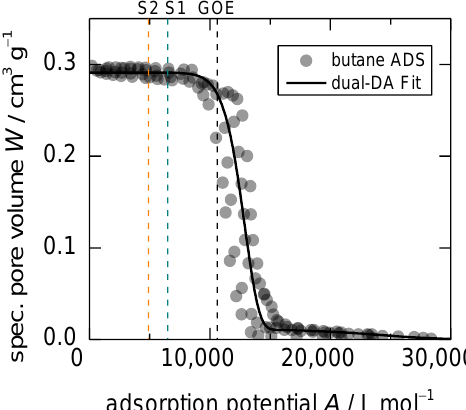
Figure 8. Dubinin plot of n -butane adsorption on 1 at 283, 298, 313, and 328 K. The position of GOE ( A GOE = 10,600 J mol − 1 ) and of the uptake equilibria for dA GO = 4100 J mol − 1 (S1: A = 6500 J mol − 1 ) and dA GO = 5700 J mol − 1 (S2: A = 4900 J mol − 1 ) with respect to GOE are shown as dotted lines.